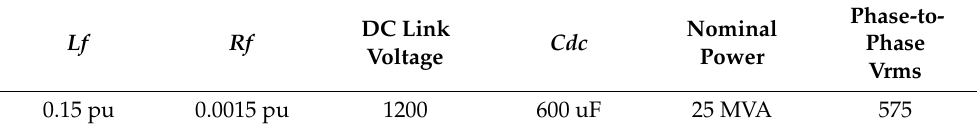
Table A5. Inverter and filter parameters.